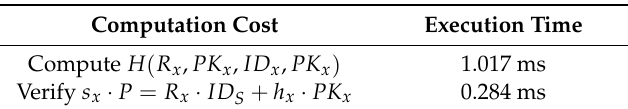
Table 3. Experiment Results at BLE-based IoT